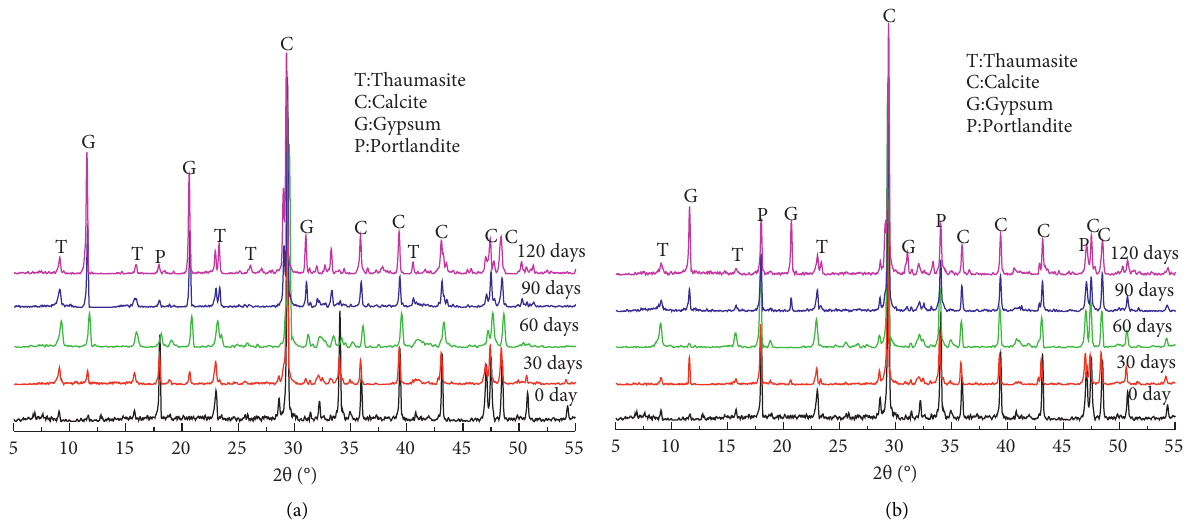
Figure 12: XRD pattern of 30% limestone powder content within 120 days. (a) Cathode surface and (b) anode surface.